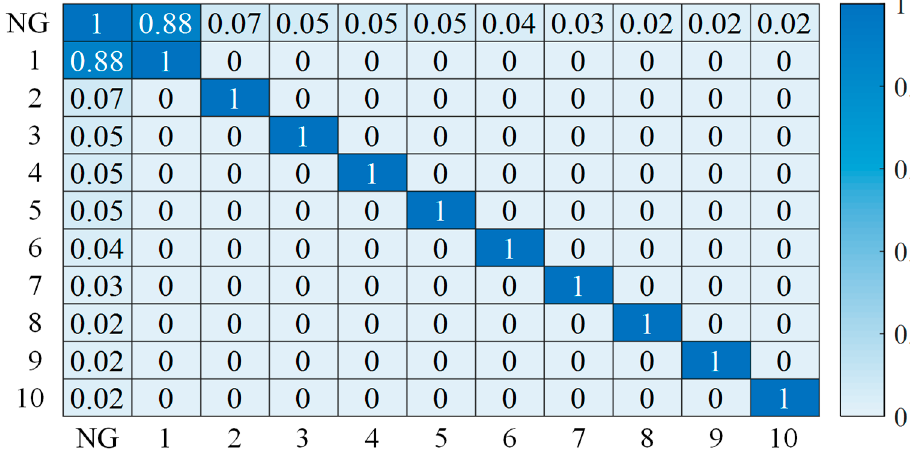
Figure 11. The components obtained by PCCA (Athens case).